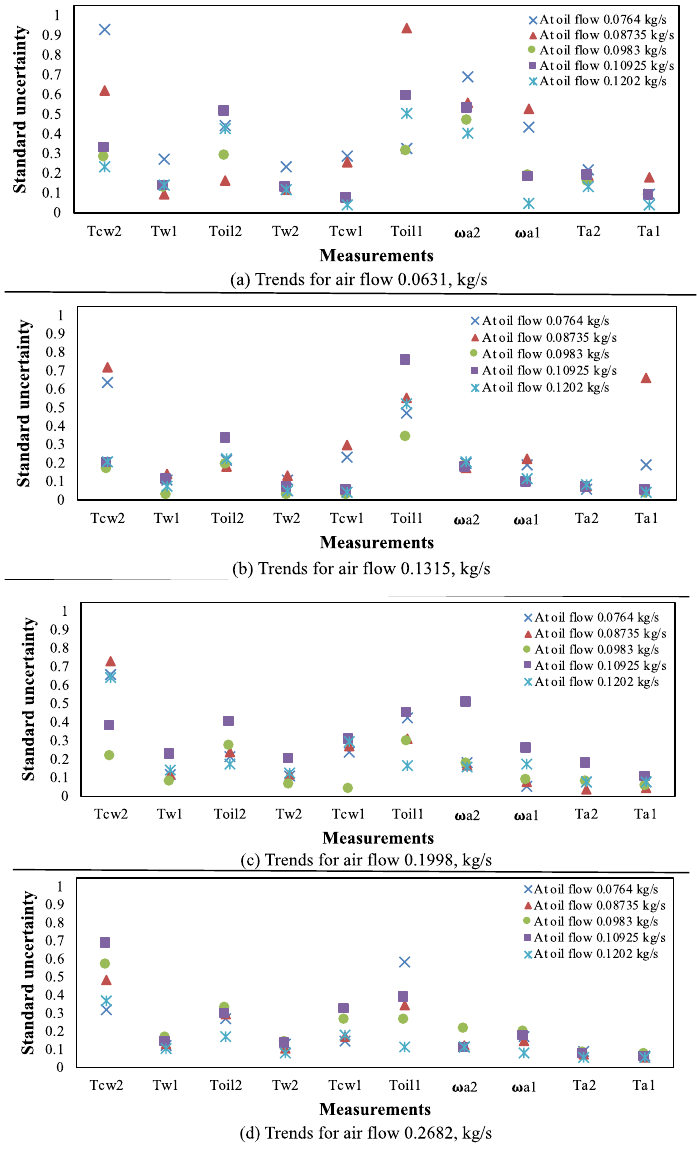
Figure A1. The standard uncertainty for the experimental measurements.